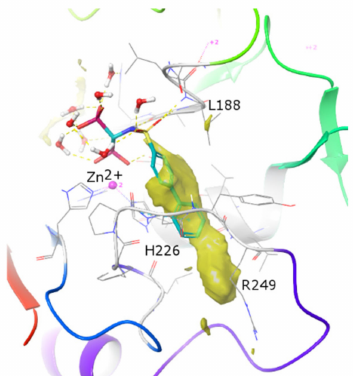
Figure 3. The molecular interaction field for the hydrophobic probe (yellow transparent surface) calculated by SiteMap [31] using default parameters in the MMP-9 S1’ site (PDB ID: 4H3X) where ML 115 has been docked, maintaining the experimental coordination geometry of the bisphosphonic group.